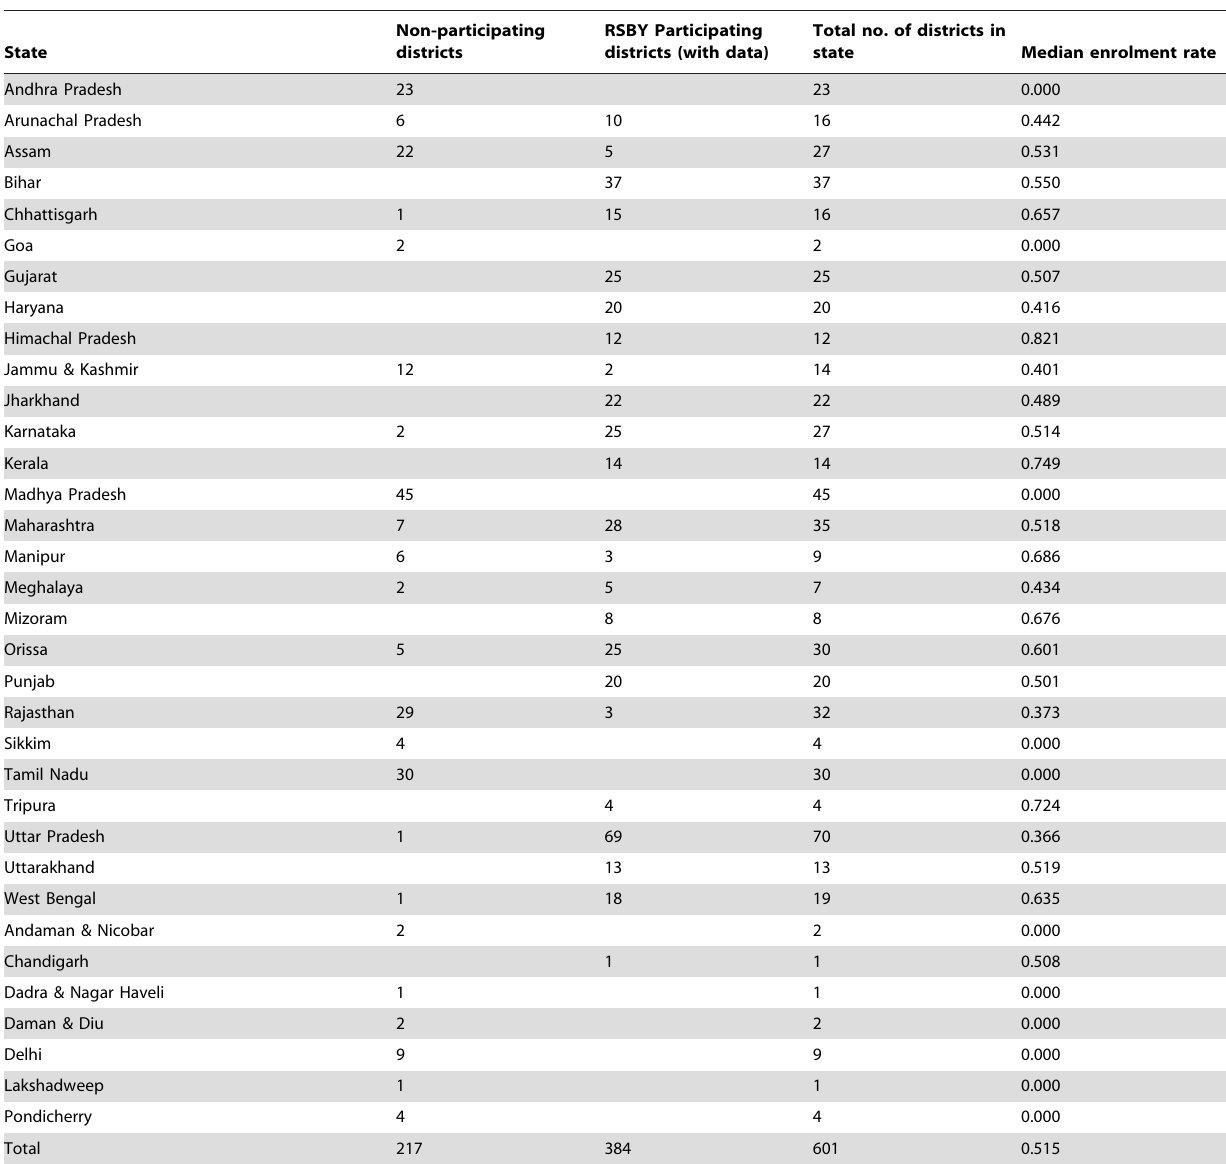
Table 1. Number of RSBY participating districts by